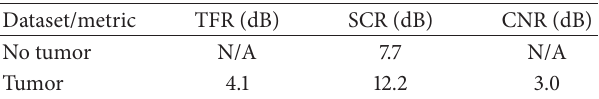
Table 4: Imaging performance metrics for each reconstructed image.